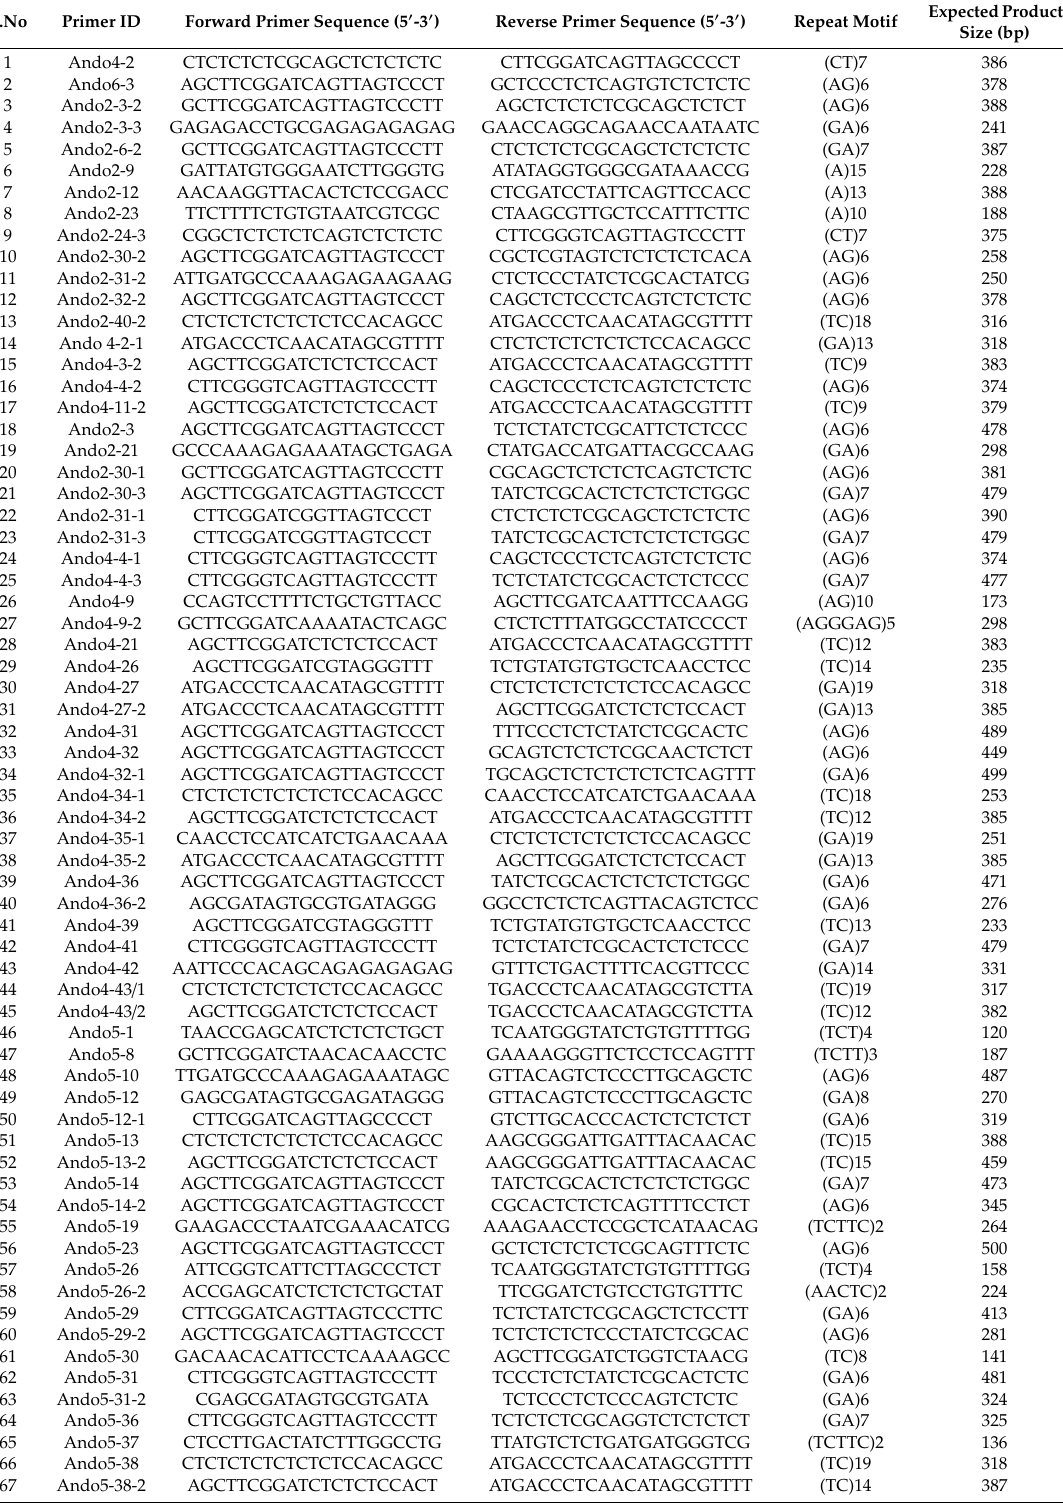
Table 2. Details of 67 novel genomic simple sequence repeat (SSR) loci developed through microsatellite-enriched genomic